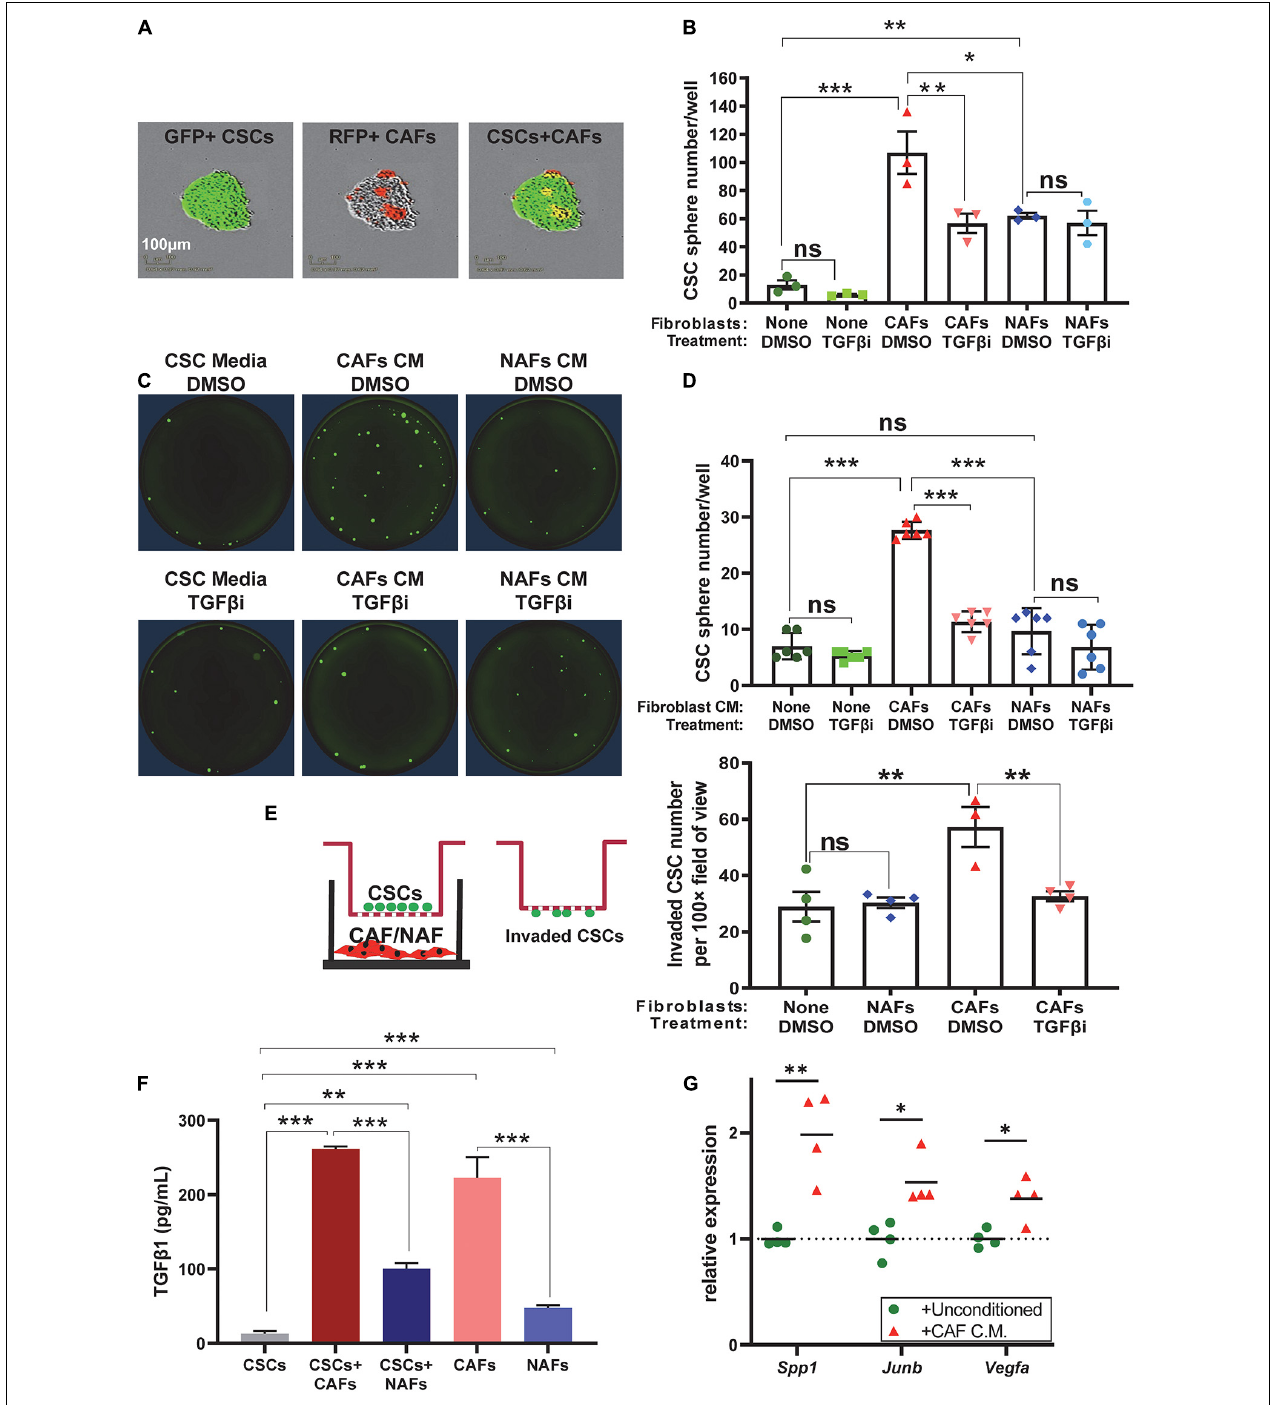
FIGURE 6 | Cancer-associated fibroblasts increased self-renewal and invasion of CSCs in a TGF β -dependent manner via direct contact and paracrine effects. (A) Representative images of GFP + A223 CSCs and RFP + CAFs in spheroid co-culture. (B) Quantification of sphere number in each of the indicated A223 CSC treatment [vehicle (DMSO) or TGF β inhibitor (“TGF β i”)] ± fibroblast co-culture conditions. (C,D) Representative images and quantification of A223 CSC spheres cultured with the indicated conditioned media (CM) and vehicle (DMSO) or TGF β i. (E) Transwell invasion assay: A223 CSCs were seeded in the top Matrigel-coated chamber, and CAFs or NAFs were cultured in the bottom well. After 48 h, invaded CSCs attached to the underside of the upper chamber were quantified. (F) TGF β 1 concentration in each of the indicated CM was determined by ELISA. Either three or four technical replicates were conducted for each cell type. (G) The CM of CAFs or unconditioned control media was applied to recipient A223 cells in a 24 h sphere initiation assay. RNA harvested from A223 recipient cells was evaluated by RT-qPCR for the expression of TGF β -target genes Spp1 , Junb , and Vegfa normalized to the expression of Gapdh . ns P > 0.05, * P < 0.05, ** P < 0.01, *** P < 0.001.